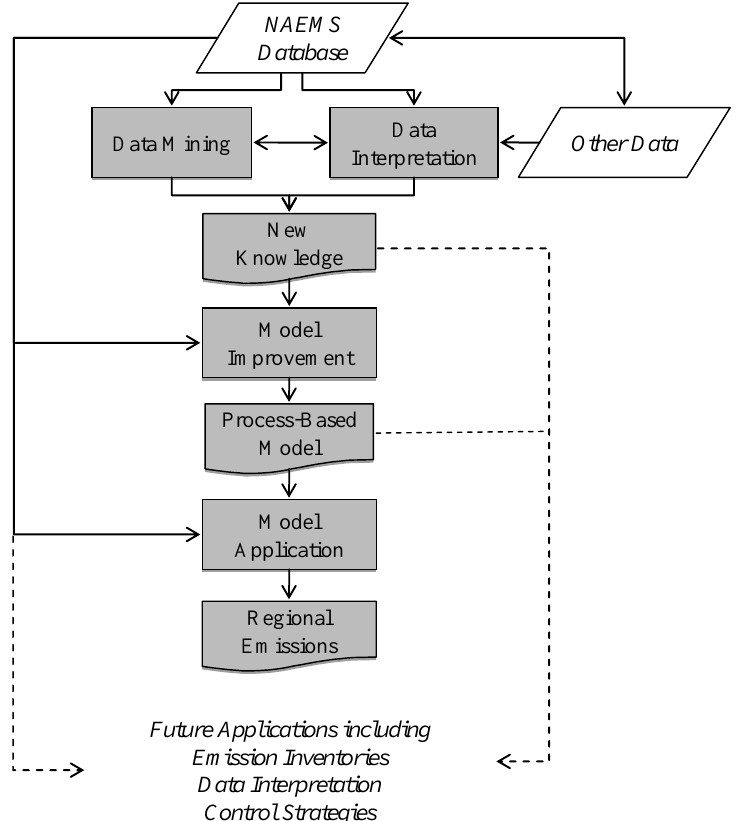
Figure 1. Diagram of the general research approaches, activities, results, and